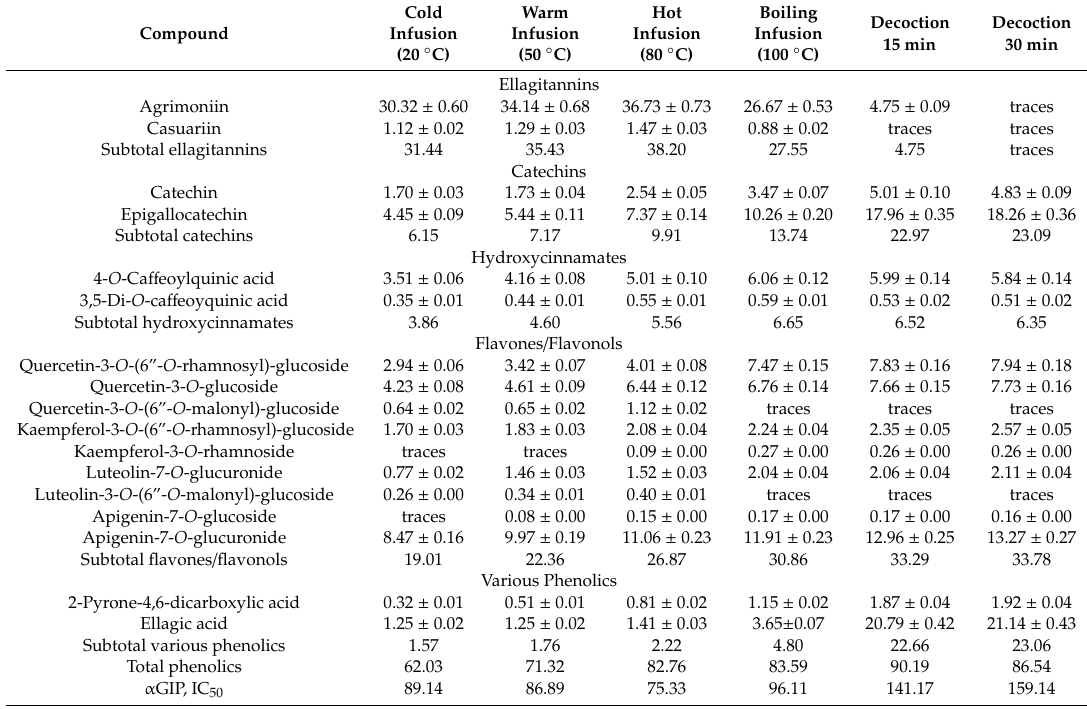
Table 4. Phenolic content in agrimonia tea infusions and decoctions (mg / 100 mL ± S.D.) and their α -glucosidase inhibiting potential ( α GIP, IC